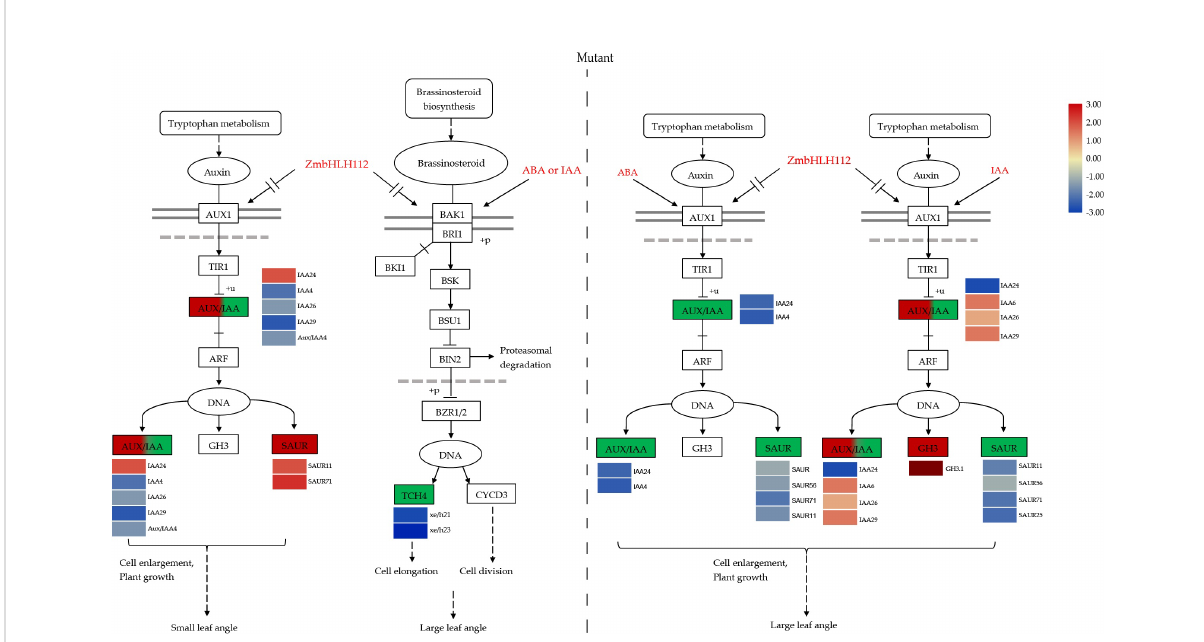
FIGURE 12 Two signaling pathways regulating maize leaf angle in the mutant bhlh112 : the auxin signaling and BR biogenesis pathways. Mutant: bhlh112